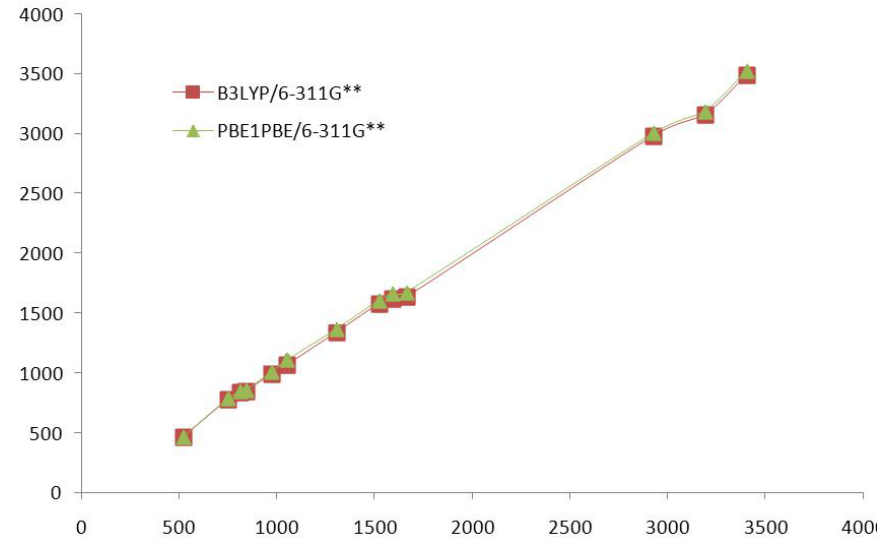
Figure 3. Comparative graph of computed frequencies [DFT] with experimental values for compound 1 .